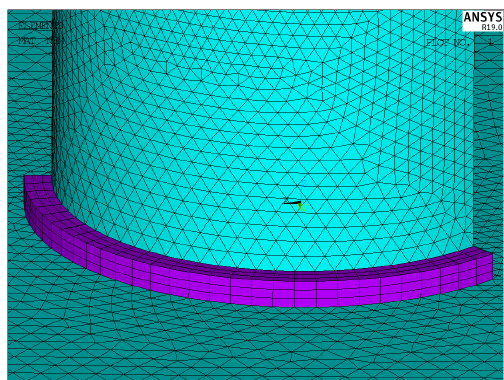
Figure 3. Meshing of finite element model for